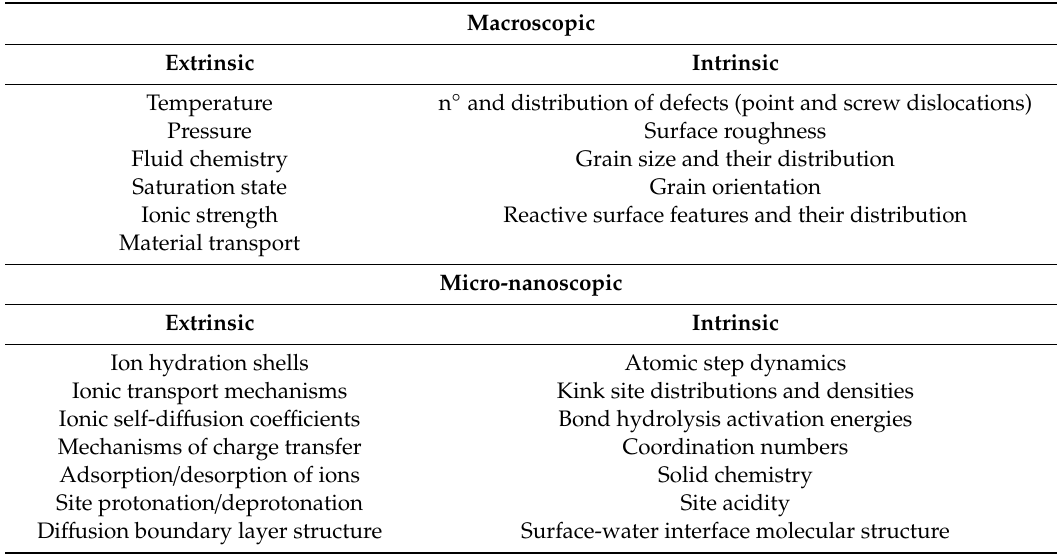
Table 1. Parameters influencing mineral dissolution